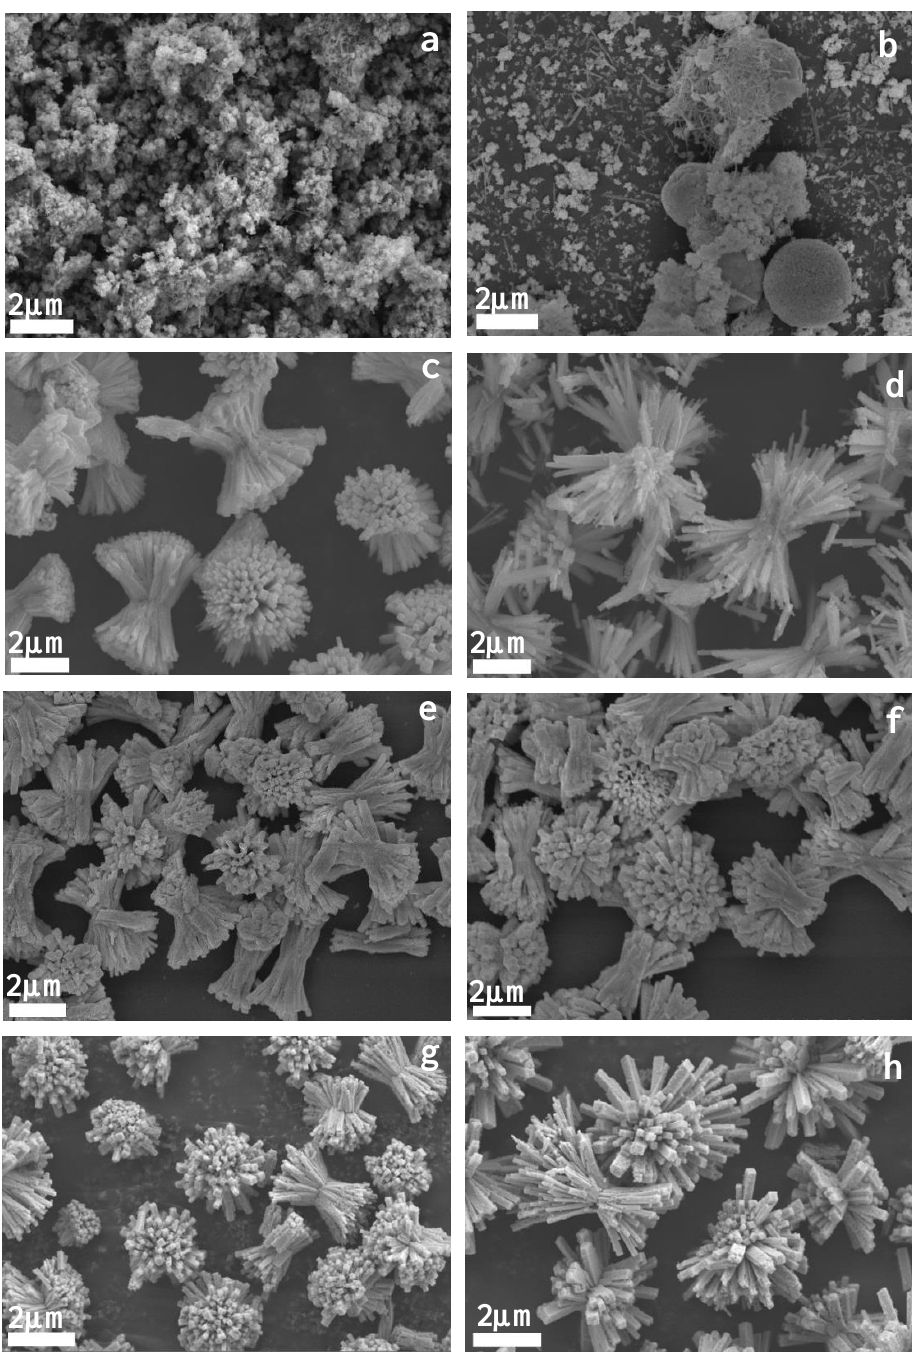
Figure 3. SEM images of CuBi 2 O 4 prepared with the hydrothermal time of ( a ) 5 min, ( b ) 10 min, ( c ) 15 min, ( d ) 0.5 h, ( e ) 1 h, ( f ) 2 h, ( g ) 8 h, and ( h ) 12 h.